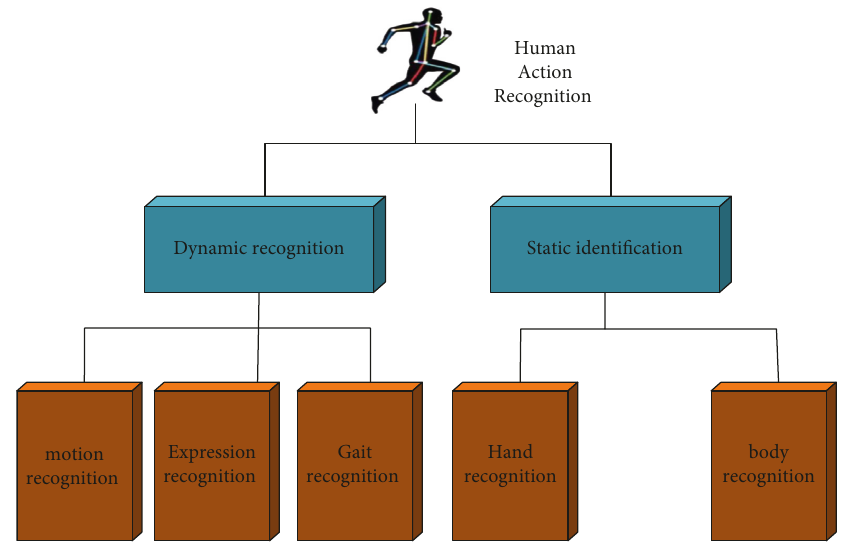
Figure 3: Basic classification of human action